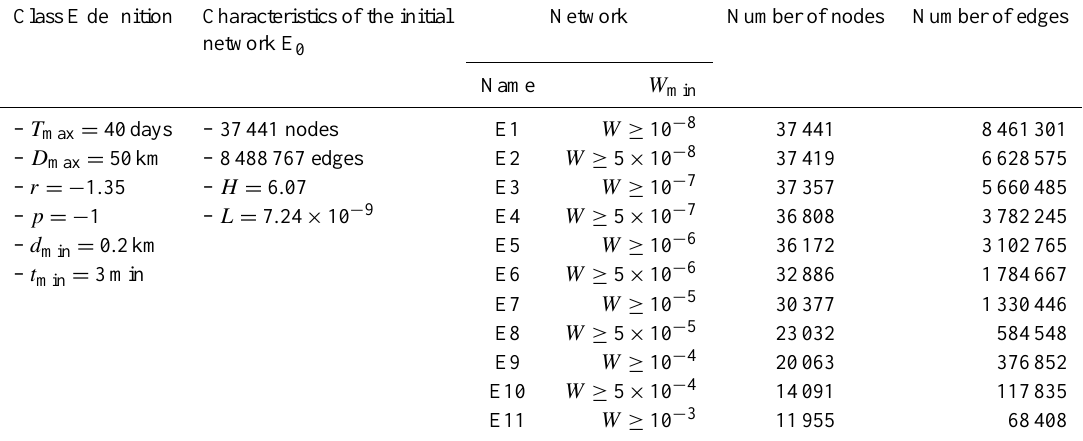
Table 2. Class E networks. E 0 is the initial network that was generated using the parameter values shown in the first column. See Table 1 for the meaning of T max , D max , r , p , d min , t min , H , and L .